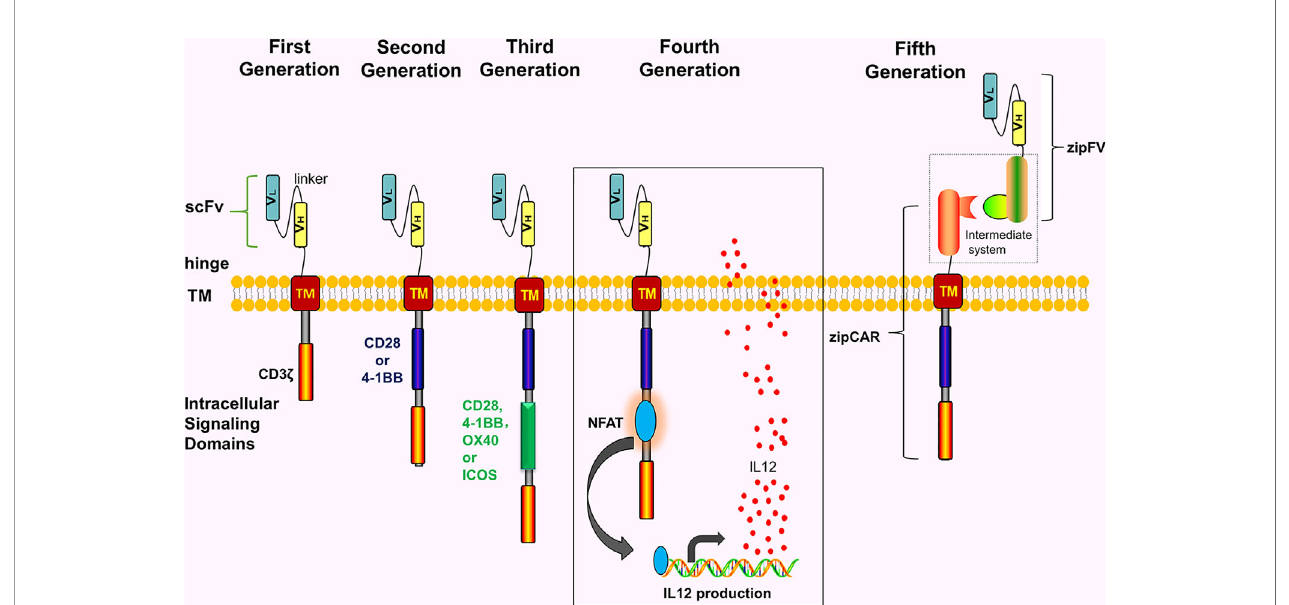
FIGURE 1 | The development of the CARs. The intracellular structure of fi rst-generation CARs only has one signal structure domain (CD3 z ) without co-stimulatory molecules. The second-generation CARs add one co-stimulatory molecule to the fi rst-generation CAR, e.g, CD28, 4-1BB, OX40 or ICOS. The third-generation CARs contain 2 costimulatory molecules. The fourth-generation CARs are modi fi ed by adding NFAT or suicide genes based on the second-generation CARs or the third- generation CARs. The fi fth-generation CARs use a “ third-party ” intermediate system to separate the antigen-binding domain of CARs from the T cell signaling